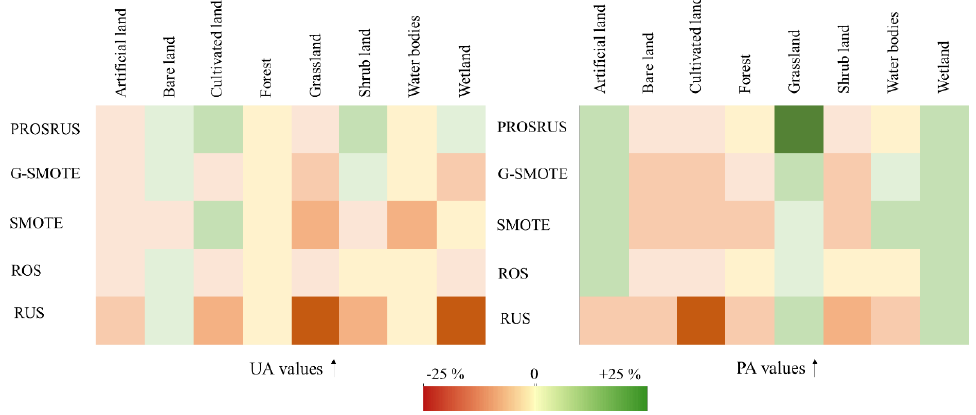
Figure 7. Effects (increase or decrease) of different balancing methods on the UA and PA values of Figure 7. E ff ects (increase or decrease) of di ff erent balancing methods on the UA and PA values of various classes in Site-1. Refer to Appendix C for more information various classes in Site-1. Refer to Appendix C for more